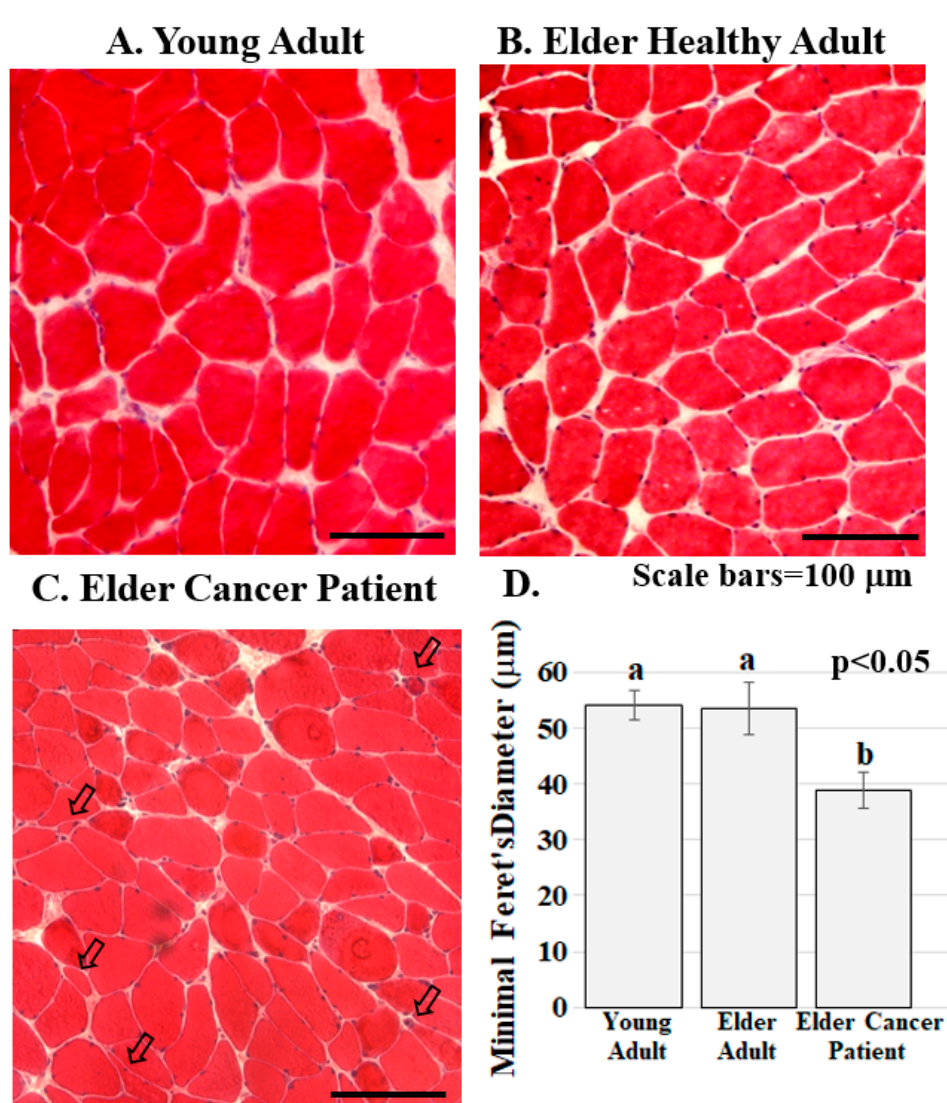
Figure 2. Skeletal muscle from cancer patients with low BMI present with abnormalities. ( A – C ). Human RA muscle sections stained with hematoxylin and eosin demonstrate that muscle structure and diameter are normal in the samples from the healthy young ( A ) and healthy elder ( B ) people while muscle from the elder cancer patients ( C ) had decreased myofiber diameter, severely atrophic, flat shaped or angulated myofibers (arrowed). Scale bars are 100 μ m; ( D ) Muscle fiber diameter is significantly lower in elder cancer patients relative to healthy young and age-matched adults. Graph bars represent mean minimal fiber diameter ( μ m) ± the standard error of the mean. Different lower-case letters represent statistical difference ( p < 0.05). All samples were stained and imaged using the same parameters in a single setting. Graph bars represent mean minimal Ferret’s diameter ( μ m) ± the standard error of the mean. Different lower-case letters represent statistical difference ( p < 0.05). Images were acquired using a Zeiss Axioscop microscope connected to a Leica DC 300F camera.